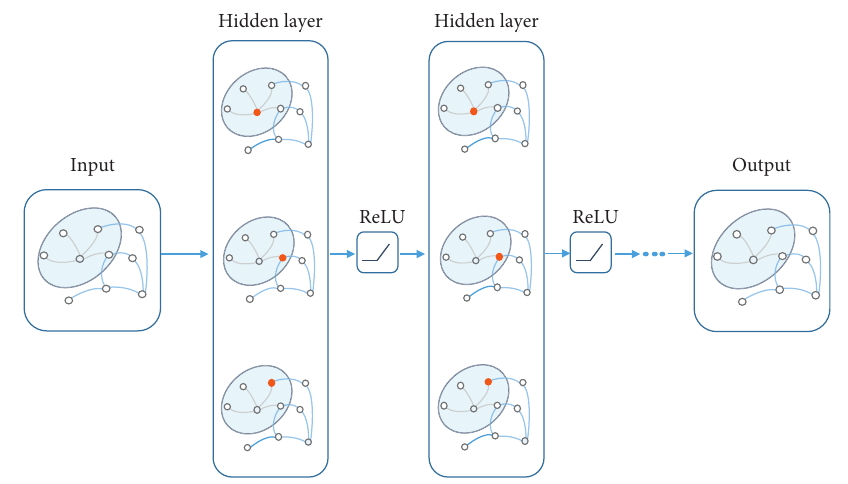
Figure 3: Structure of